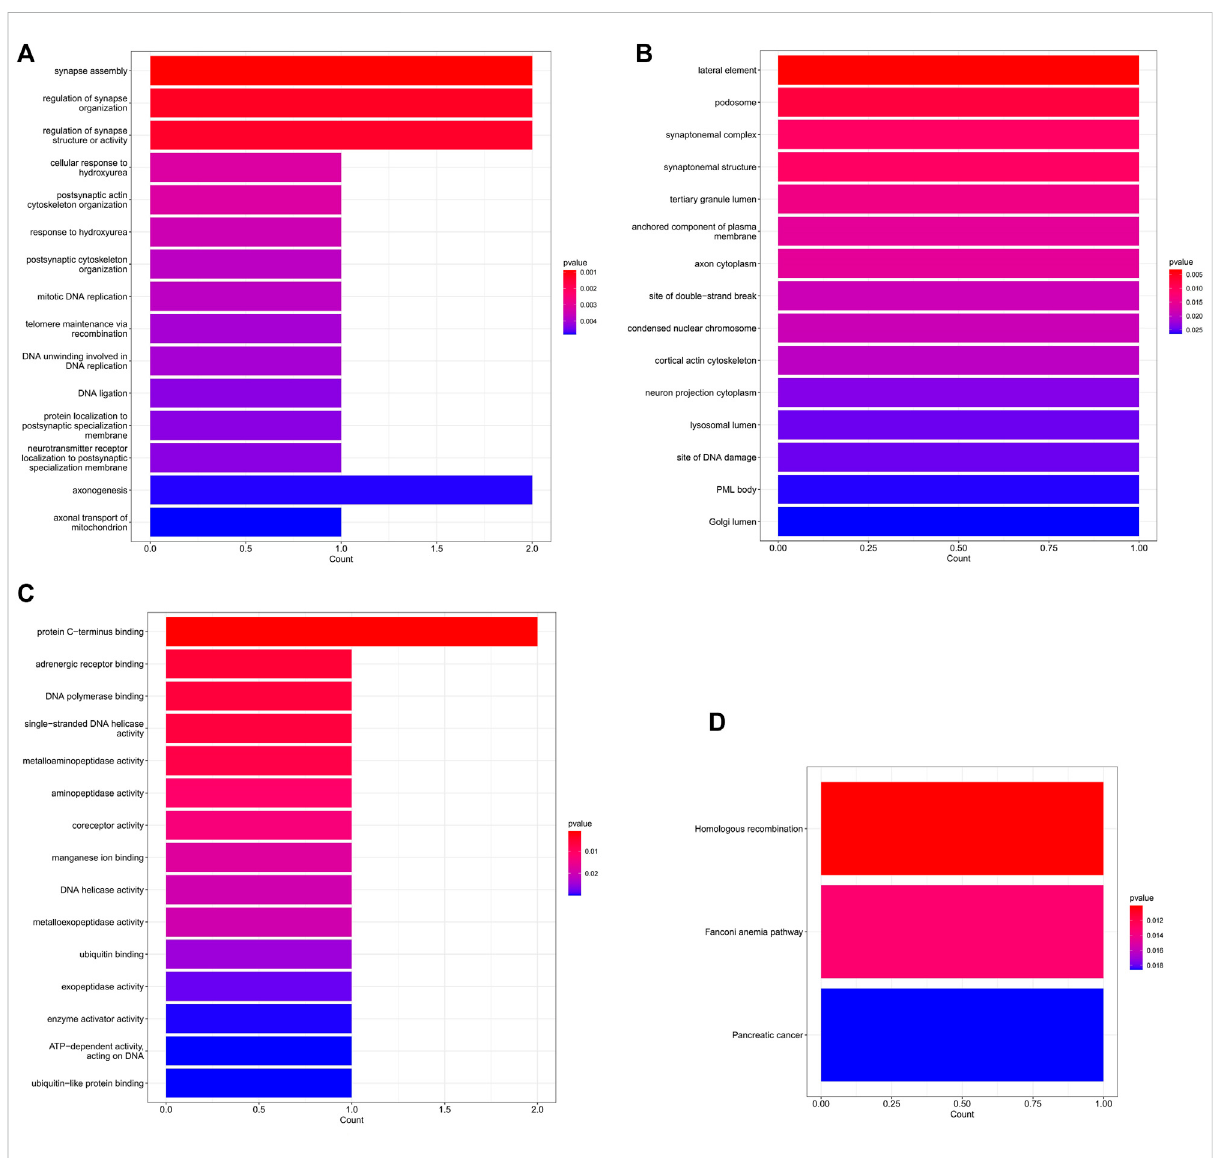
FIGURE 6 The GOand KEGGenrichmentanalysis of mRNAintheceRNA network. (A) Thetop 15GO termsofbiologicalprocess. (B) The top 15GO terms of cellular component. (C) The top 15 GO terms of molecular function. (D) The 3 KEGG